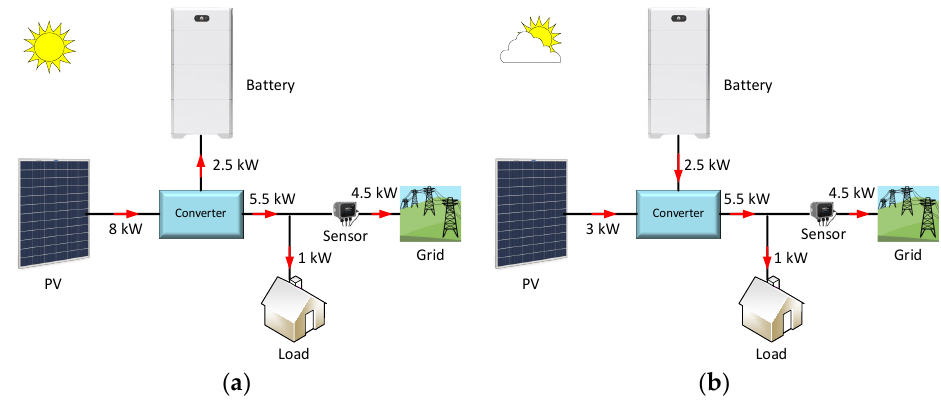
Figure 13. Examples of the fully fed to the grid strategy.